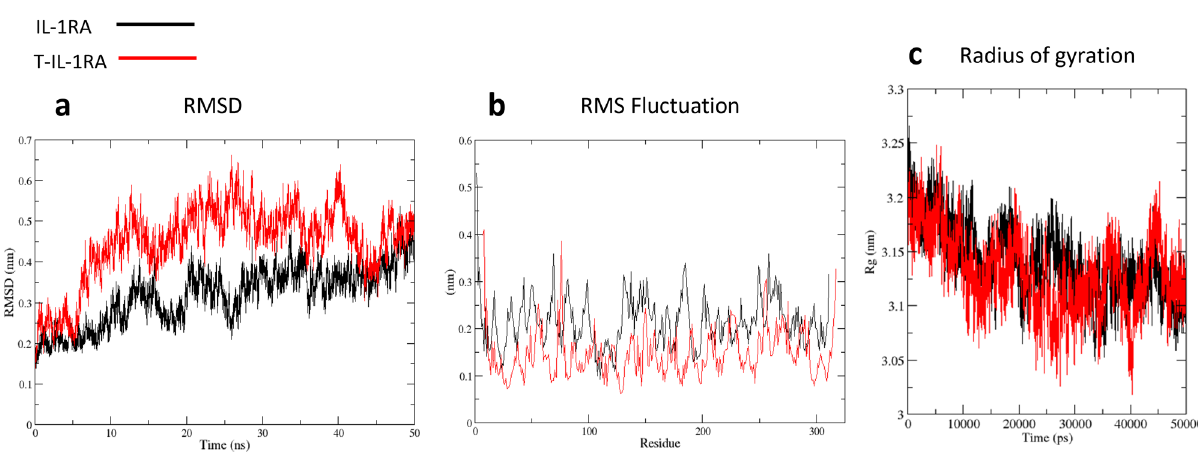
Figure 5. Molecular dynamic output analyses. ( a ) Root-mean-squared deviation plot ( b ) Root-mean-squared fluctuation plot and ( c ) Radius of gyration plot for each system over each 50 ns production